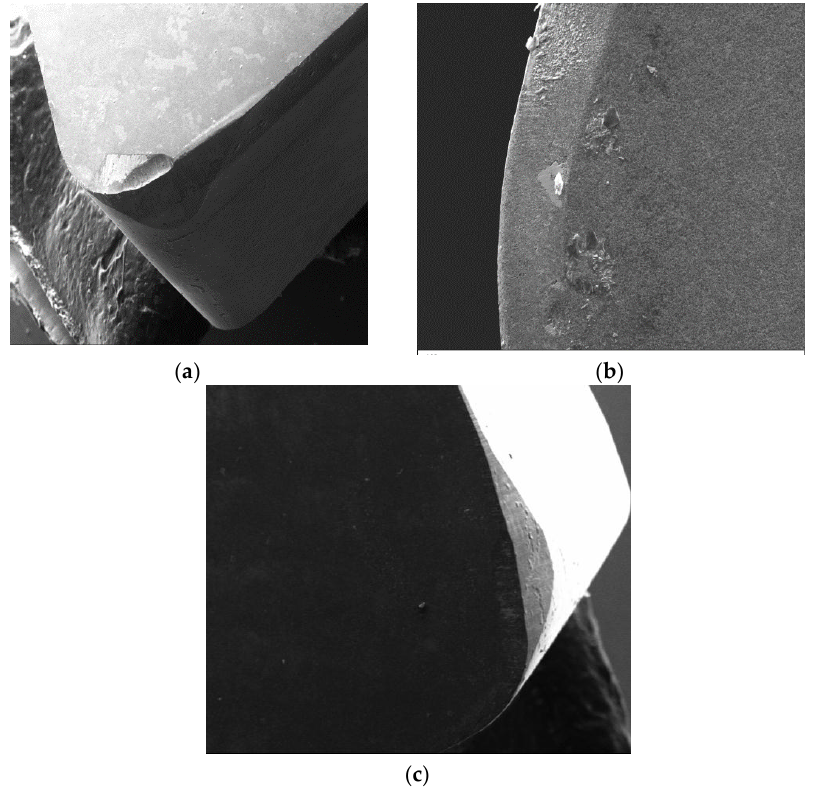
Figure 4. Tool wear images patterns ( a ) CBN-I ( b ) CBN-II ( c ) CBN-III highlighting the abrasion arks on rake face and Flank Wear on Flank Face.